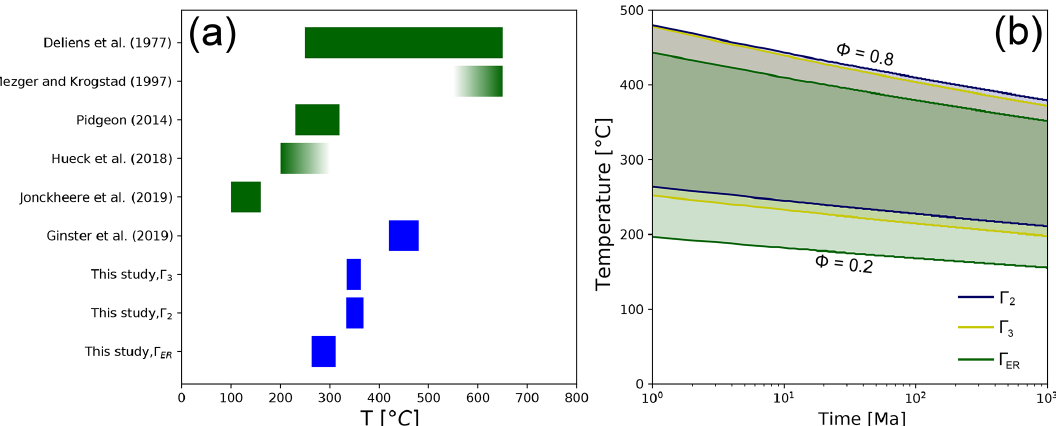
Figure 9. (a) Zircon radiation-damage closure temperatures T c based on annealing experiments (blue) and geological data (green). (b) Partial annealing zones for the JMAK models for (cid:48) 2 , (cid:48) 3 , and (cid:48) ER for residence times between 1Ma and 1Ga. The shaded colors correspond to the extent of the partial annealing zones for the three Raman